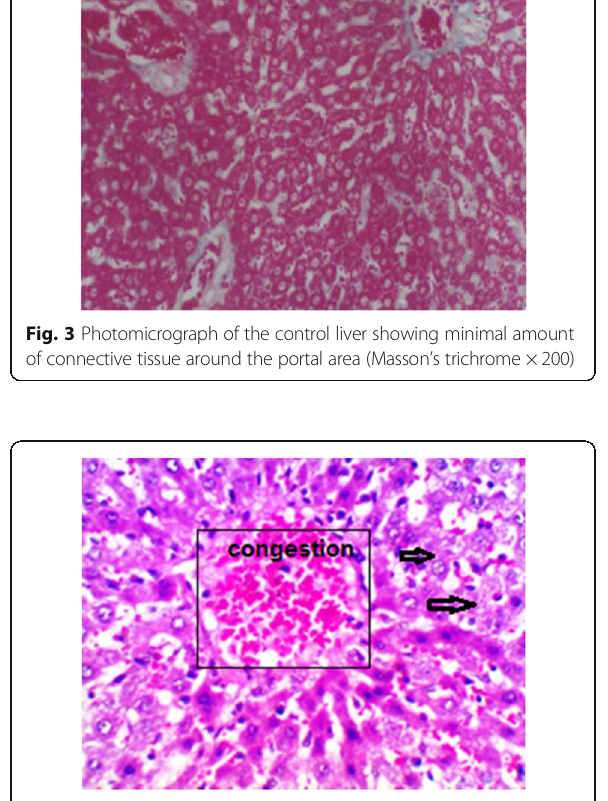
Fig. 7 Photomicrograph of CCl4-treated liver sections showing necrosis area with pyknotic nuclei (H&E;